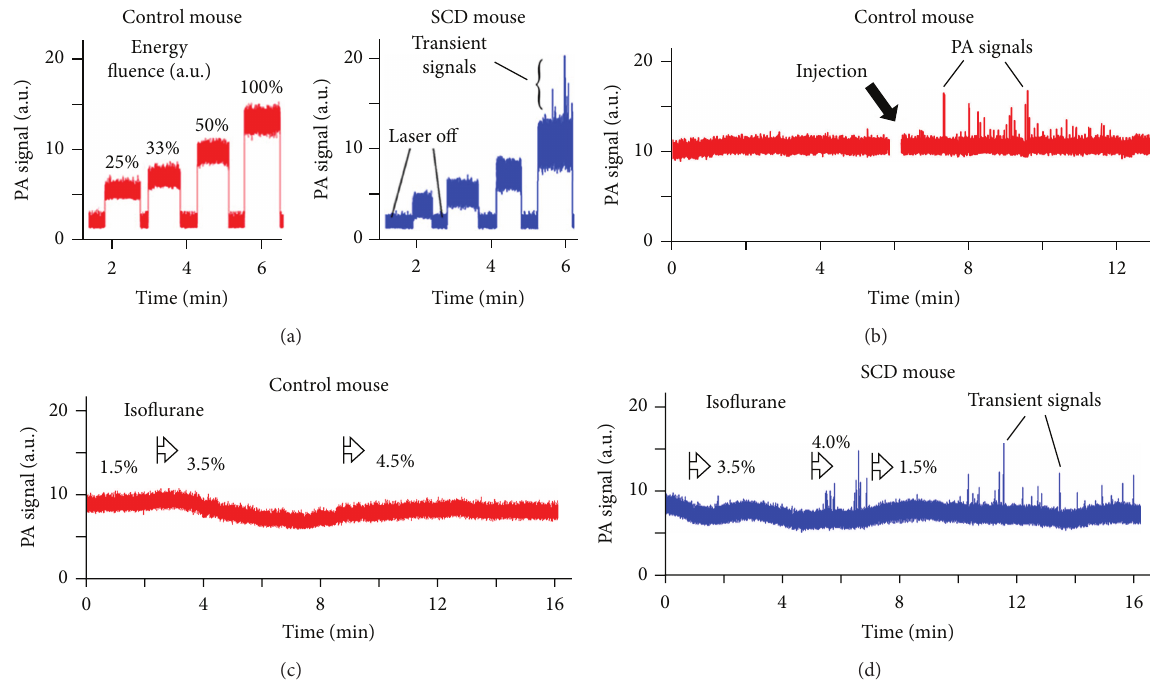
Figure 7: In vivo PAFC of sRBCs in SCD mice. (a) Typical in vivo PA signal traces from mouse ear microvessels (veins) at different laser energy fluence (relative units) for control nude (left) and SCD (right) mice. (b) In vivo PA signal trace after intravenous injection of 100 𝜇 L of SCD mouse blood into healthy mouse blood circulatory system. (c, d) In vivo PA signal traces in normal nude mice (c) and SCD mice (d) during isoflurane induced hypoxia. Laser parameters: wavelength, 820 nm (a–d); laser energy fluence, 10–600 mJ/cm 2 (a) and 500 mJ/cm 2